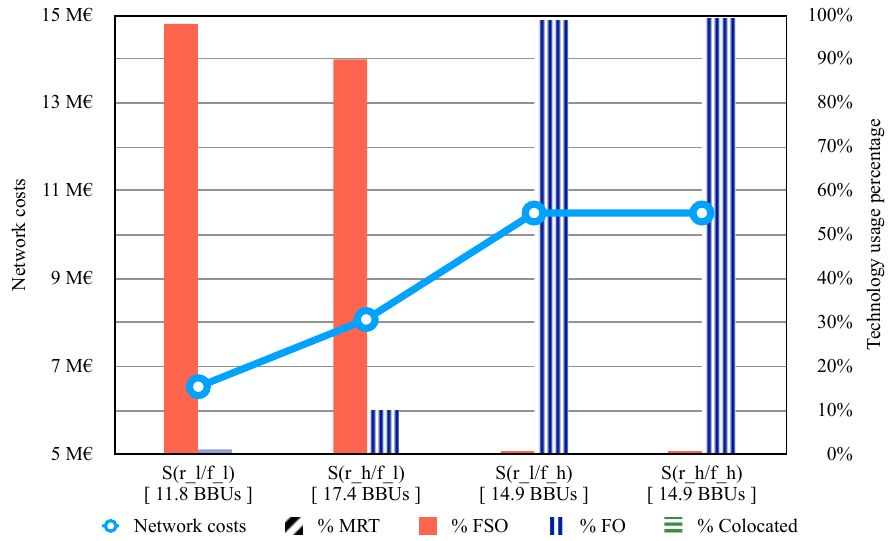
Figure 10. Network costs and technology usage for the urban